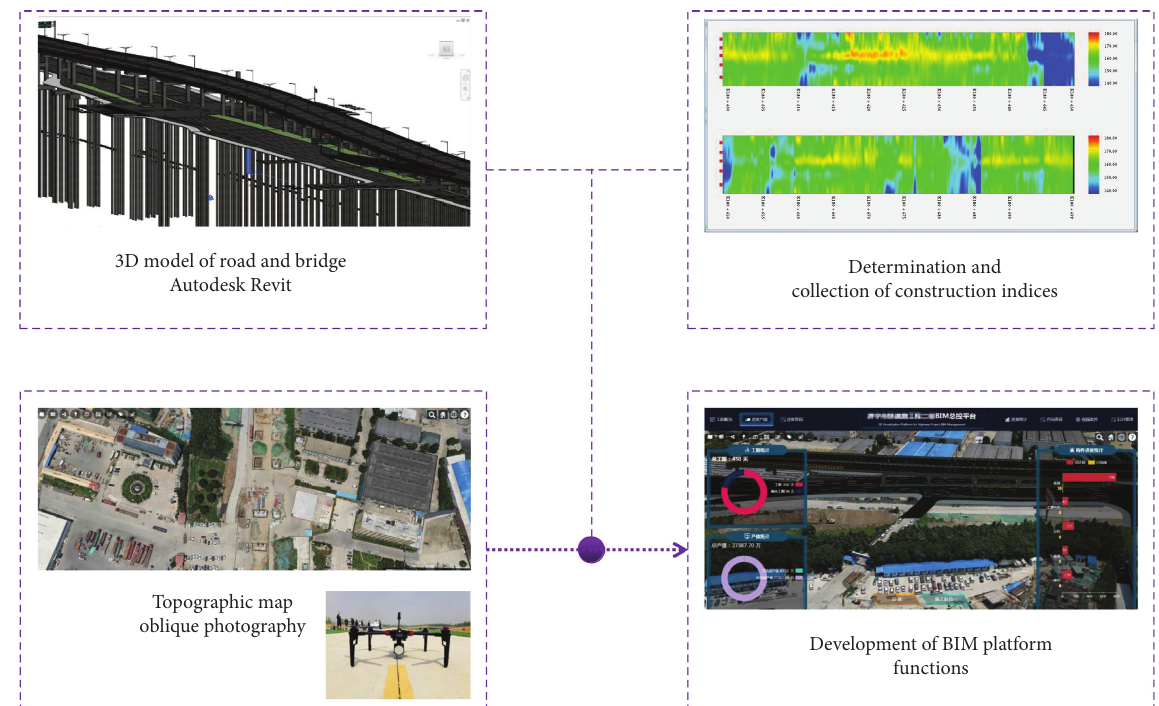
Figure 7: Process of building the BIM platform.